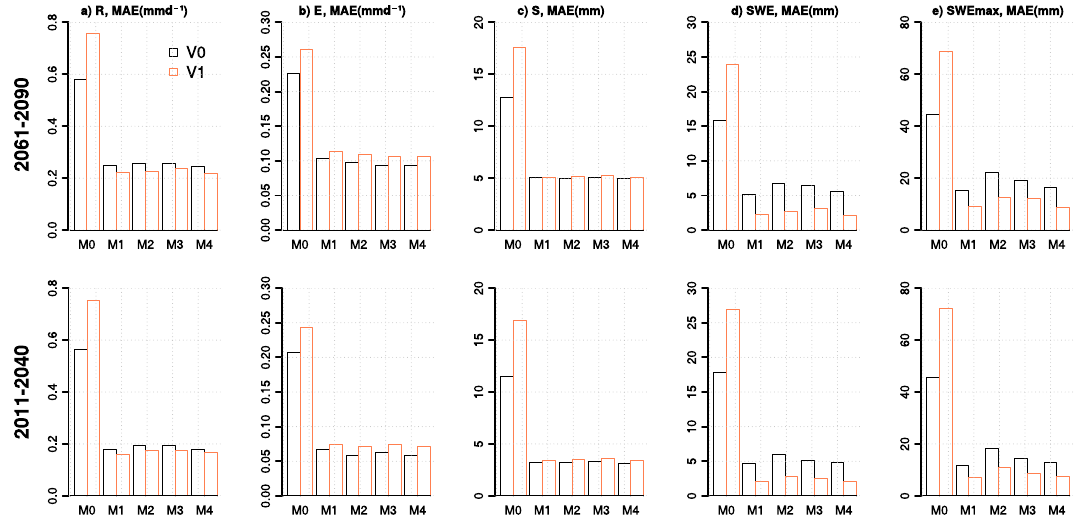
Figure 6. Similar to Figure 5 but for the cross-validated MAE of monthly mean ( a ) total runoff, ( b ) evapotranspiration, ( c ) soil moisture, ( d ) snow water equivalent and ( e ) the mean annual maximum of snow water equivalent in years ( bottom ) 2011–2040 and ( top )